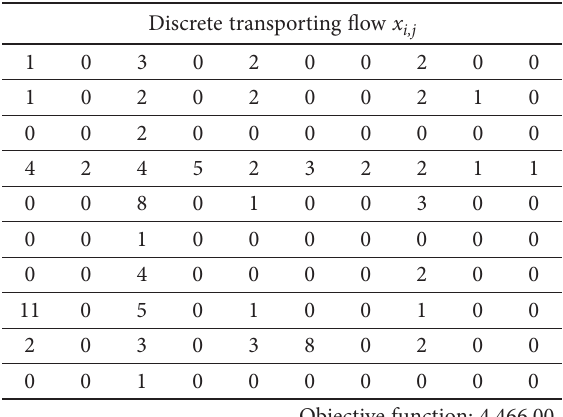
Table 9 . Best obtained discrete solution for the 10×10 test problem with cost function C